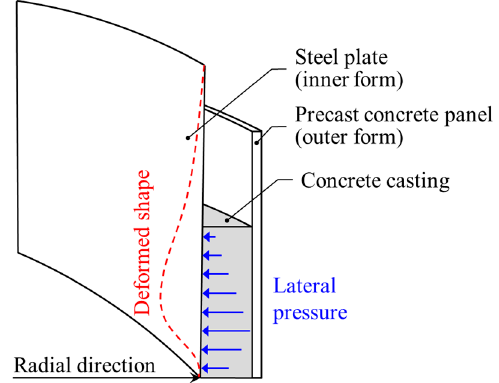
Figure 3. Detailed drawing showing the deformation of the steel plate under lateral pressure during concrete casting.